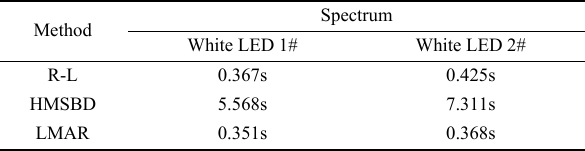
Table 3 Computation speed of each